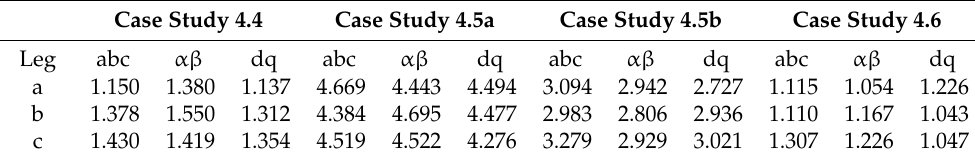
Figure 9. Steady-state analysis of current loop under distorted grid voltages, without feedforward compensation. ( a ) abc–PR, ( b ) αβ –PR, and ( c ) dq–PI. Table 5. Experimental results from case studies—total demand distortion TDD (%).